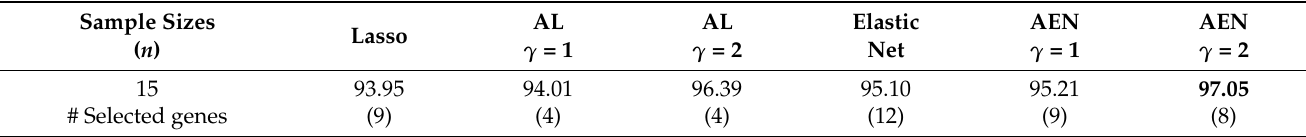
Table 7. The average percentage of accuracy and the average number of selected genes of lasso, adaptive lasso (AL), elastic net, and adaptive elastic net (AEN) under 20 leukemia genes . Table 8. The average percentage of accuracy and the average number of selected genes of lasso, adaptive lasso (AL), elastic net, and adaptive elastic net (AEN) under 30 leukemia